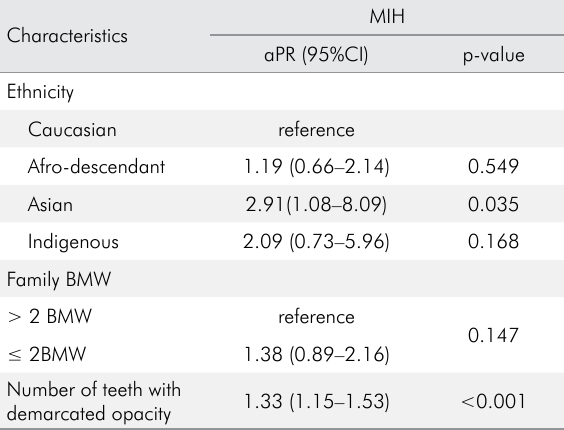
Table 4. - Adjusted prevalence ratio ( to number of DDE in primary teeth and socioeconomic characteristics of the sample. (Curitiba, Brazil,